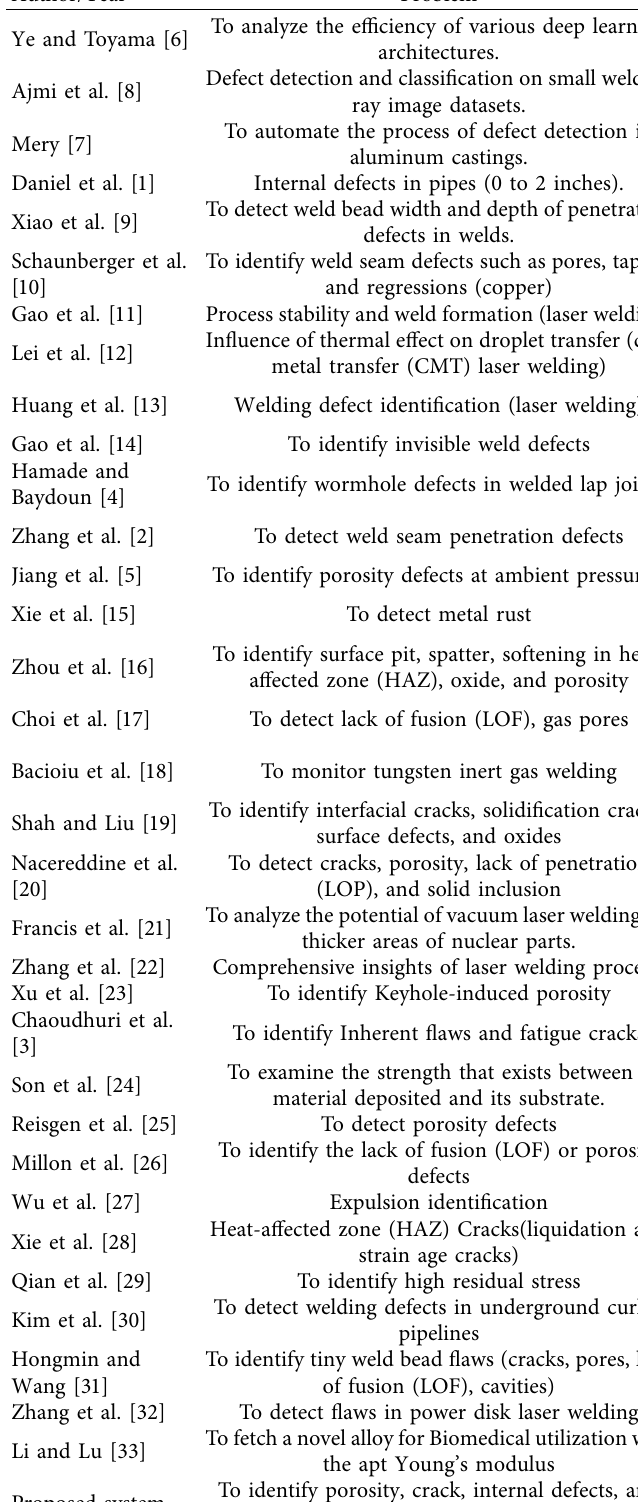
Table 2: Recent research work related to defect